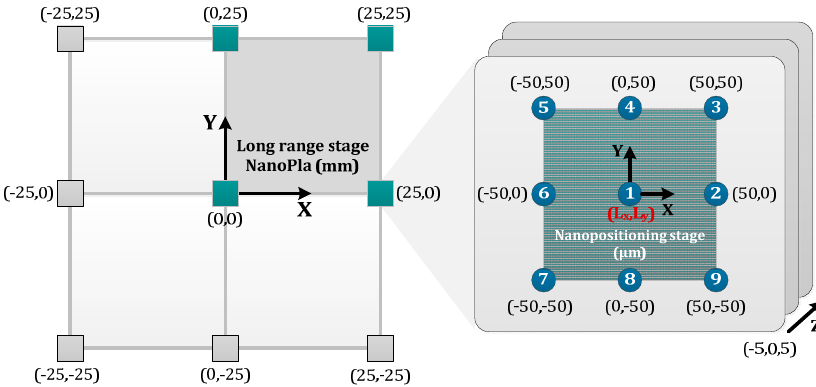
Figure 9. Studied positions in the NanoPla error budget: critical long range stage location (25,0) mm and three-level grid of short range displacements (±50 μ m in XY-plane and ±5 μ m along Z-axis). ( Left ) XY-long range motion schematization; ( Right ) XYZ-nanostage extreme positions.